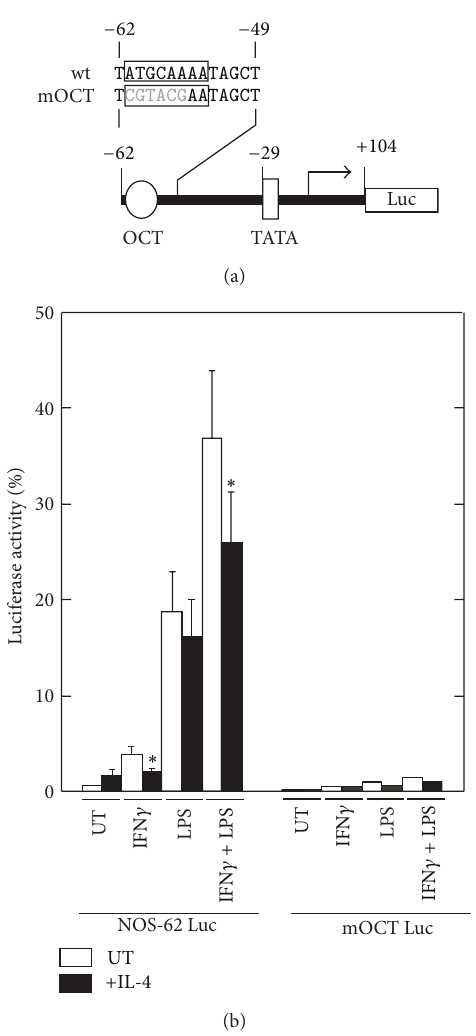
Figure 5: The OCT site in the Nos2 promoter region is required for IFN 𝛾 - and LPS-induced promoter activity. (a) The diagram shows the wild-type (wt) and mutant sequences of the OCT site (mOCT) in the Nos2 minimum promoter region. The numbers above the promoter region refer to the nucleotide positions relative to the transcription start site of the mouse Nos2 gene. (b) RAW264.7 cells were transiently transfected with the NOS-62 luciferase reporter construct or a mutant construct containing a mutated OCT site (mOCT), as described above. The relative luciferase activities are shown as percentages of the activity in cells transfected with the wild-type construct (pNOS-996) and stimulated with IFN 𝛾 and LPS. Each column and bar represents the mean ± SEM of three independent experiments. The asterisks denote a statistically significant difference compared to the cultures treated with IL-4 ( 𝑃 < 0.05 , Student’s 𝑡